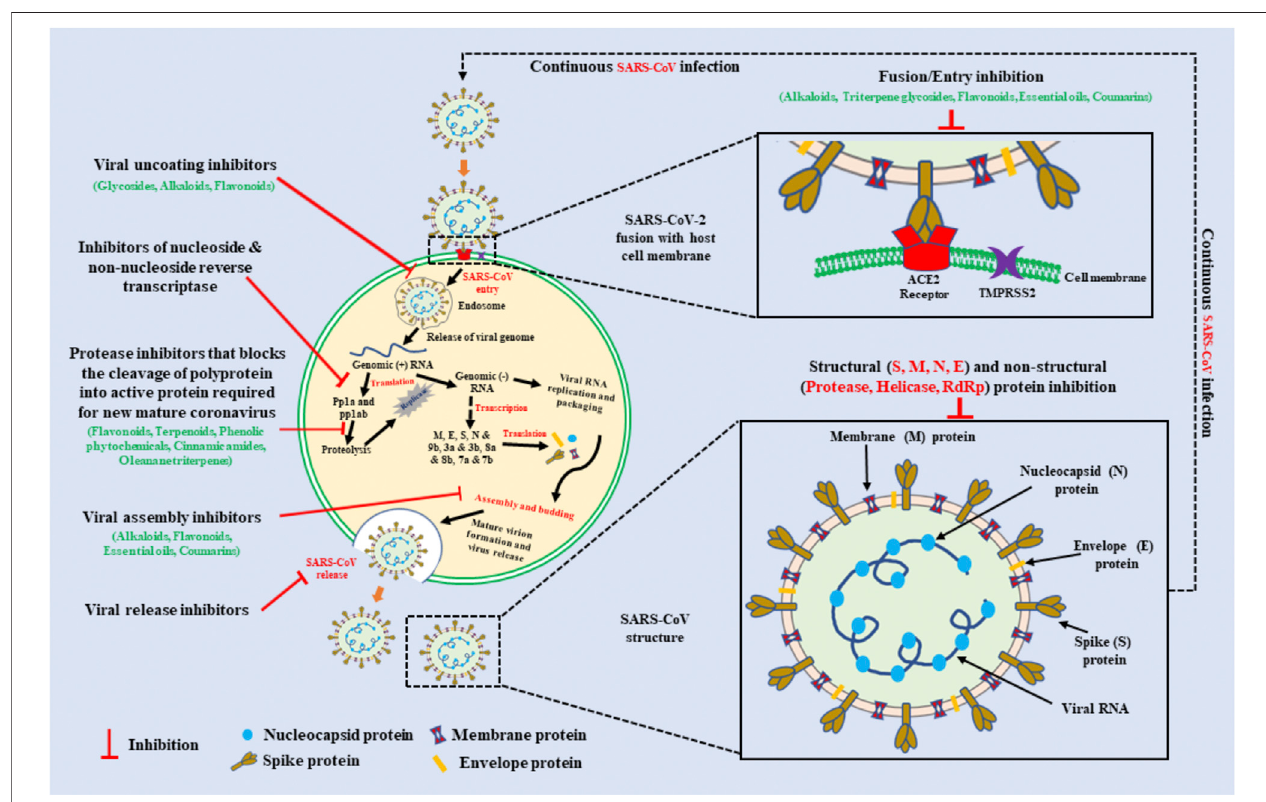
FIGURE1| SchematicrepresentationofaCoronavirusreplication cycle,SARS-CoVvirusstructure,andthemolecular targetsfornaturallyoccurringplantextracts and their active compounds against on viral infection. For attachment with host cells, SARS-CoV S protein use the cellular attachment factor Angiotensin-converting enzyme 2 (ACE2) and the cellular protease Transmembrane protease serine 2 (TMPRSS2) for their activation. SARS-CoV enters into host cells via endocytosis and release its RNA genome inside the cell. Further early and late protein synthesis occurs. Finally, viral assembly and then release outside the cells via exocytosis. The natural compounds that can target at different stages of viral replication may inhibit SARS-CoV infection. Inhibitors derived from plant sources such as alkaloids, glycosides, phenolic phytochemicals, essential oils, coumarins, cinnamic amides, and oleanane triterpenes may provide great treatment. Schematic diagram of SARS- CoVvirusstructurerepresentsthesinglestrandedpositive-senseviralRNA,Spike(S),Nucleocapsid(N),Membrane(M),andEnvelope(E)protein.Bioactivecompounds that can inhibit structural and non-structural proteins of coronaviruses can be used with inhibitors of viral replication cycle.